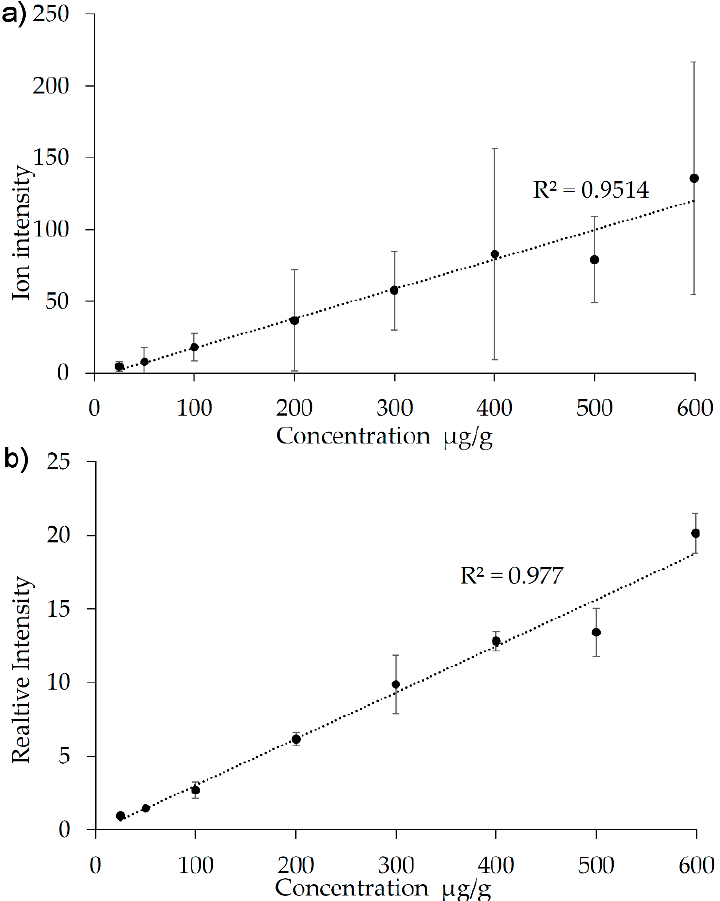
Figure 5. Calibration curve based on a mimetic tissue model in porcine skin with and without normalization to the internal standard. ( a ) Without normalization. ( b ) With normalization to the reserpine signal at m/z 609.2804. The error bars show the standard variation calculated from measurements on neighboring sections of the calibration block on three consecutive days.